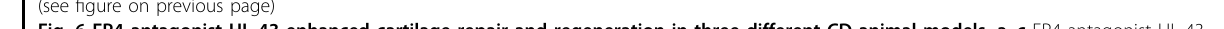
Fig. 6 EP4 antagonist HL-43 enhanced cartilage repair and regeneration in three different CD animal models. a – c EP4 antagonist HL-43 induced cartilage regeneration in MF surgery-induced CD rat model. Macroscopic appearance of the articular cartilage, H&E staining and S.O. staining of the sham and defect cartilage 6 weeks after MF surgery were shown ( a ). Black dotted boxes indicate the defect region. The International Cartilage Repair Society (ICRS) macroscopic score and ICRS Visual Histological Score of regenerated tissues analysis was analyzed ( b , c ). n = 4 for each group, scale bar = 500 μ m. Error bars are means ± s.d., * P < 0.05, ** P < 0.01 by ANOVA and LSD post hoc test. ns, not signi fi cant. d EP4 antagonists induced the mature cartilage formation in MF surgery-induced CD rat model. Joint sections from Sham, Vehicle (Veh), Grapiprant and HL-43-treated rats were stained with antibodies against Col2, Acan, Col1, and ColX. Nucleus were shown by DAPI staining. Scale bars are 100 μ m. Dotted lines indicated the surface of articular cartilage. e EP4 antagonist HL-43 alleviated OA in the DMM surgery-induced CD mouse model. The corresponding Osteoarthritis Research Society International (OARSI) scores were compared. Error bars are means ± s.d., n = 8 for each group, ** P < 0.01, *** P < 0.001, **** P < 0.0001 by ordinary one-way ANOVA with multiple comparison using Tukey method. ns, not signi fi cant. f , g The relief of the pain by treatment of HL-43 in the DMM surgery-induced CD mouse model. Von Frey assay ( f ) and radiant heat paw-withdrawal test ( g ) were measured in each group 6 weeks after DMM surgery. n = 8 for each group in Von Frey assay, n ≥ 6 for radiant heat paw-withdrawal test, * P < 0.05, ** P < 0.01, *** P < 0.001 by ANOVA and LSD post hoc test. h EP4 antagonist HL-43 induced cartilage regeneration in the aging-induced CD mouse model. Articular cartilage thickness of the tibia plateau at same position was measured. Error bars are means ± s.d., n = 9 for the vehicle and HL-43-treated groups, n = 6 for Celecoxib treated group, * P < 0.05, *** P < 0.001 by one-way ANOVA with multiple comparison using Tukey method. i EP4 antagonist HL-43 induced cartilage regeneration in the aging-induced CD mouse model. Representative images of S.O. staining of knee joint sections in aged mice (21-month-old), which treated with 30 mg/kg vehicle, Celecoxib, and HL-43 daily from 19 to 21 months by gavage. Scale bar, 200 μ m. Immunostaining of knee joint sections from each group with indicated antibodies. Scale bar, 100 μ m. Dotted lines indicated the surface of articular